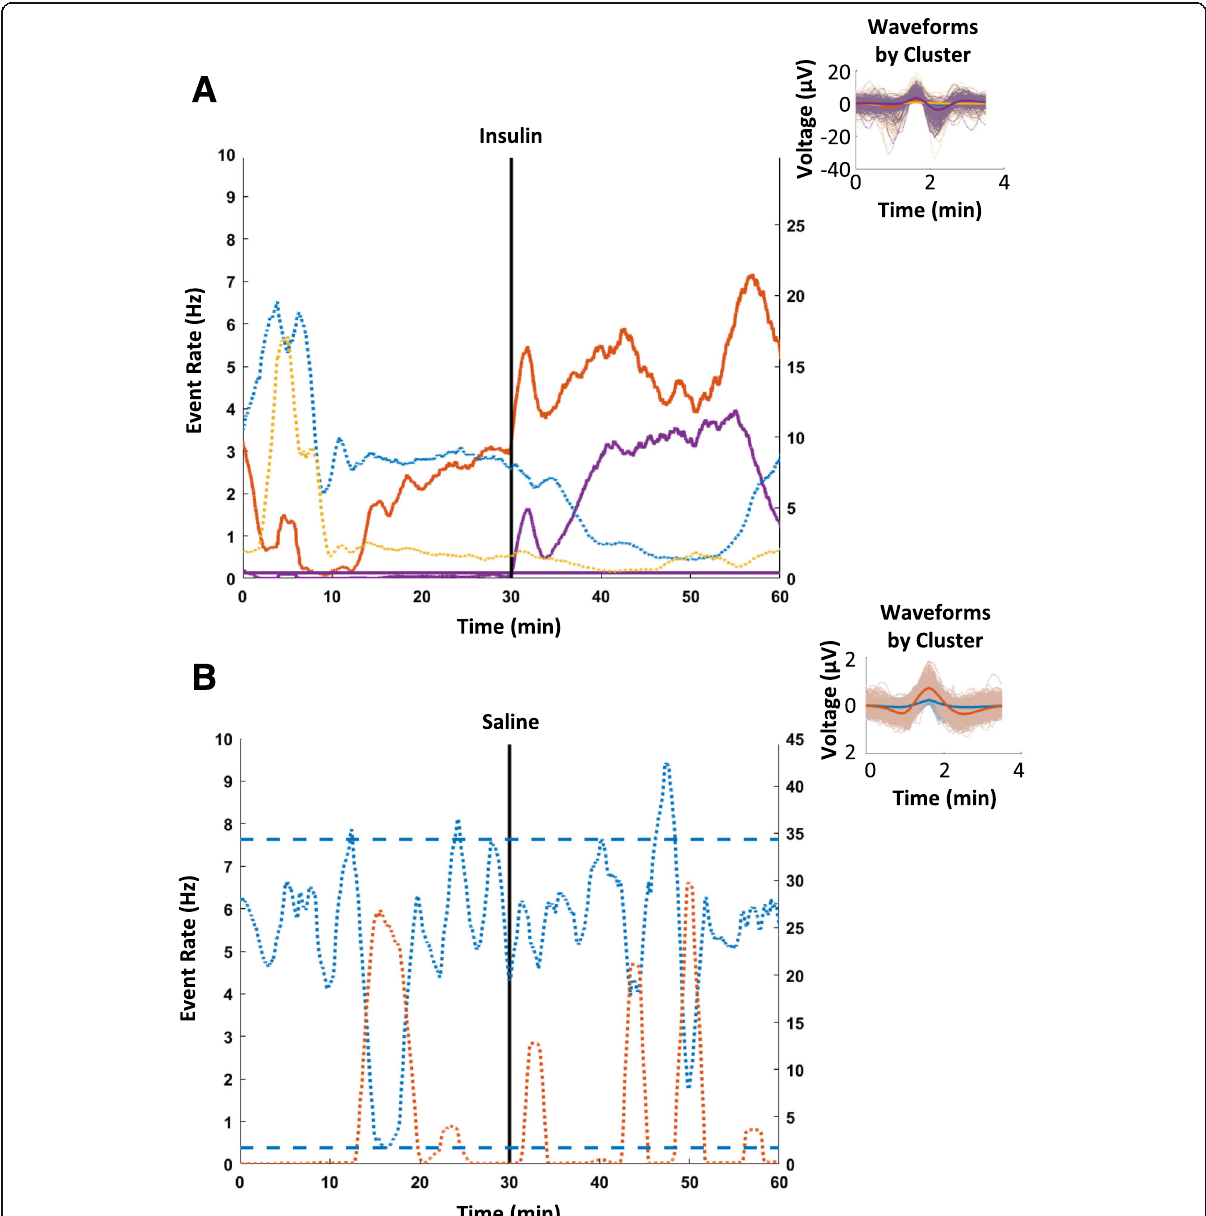
Fig. 2 Indicative neural responses to different injections. Each colored trace represents the response rate over time of a different CAP – solid lines correspond to lower firing rate CAPs (maximum of 10 CAPs/sec) and dotted lines corresponds to high firing rate CAPs (maximum of 30 – 45 CAPs/sec). The injection is indicated by a vertical black line occurring at 30min. The thresholds encapsulating the baseline statistics of a particular CAP are indicated by horizontal lines of the same color. An example of a insulin VN response curves that include a CAP that increases its firing rate, along with their respective CAP waveforms and b an example of neural responses to the saline injections control, where there are no discernible responses to the injection, along with the respective CAP